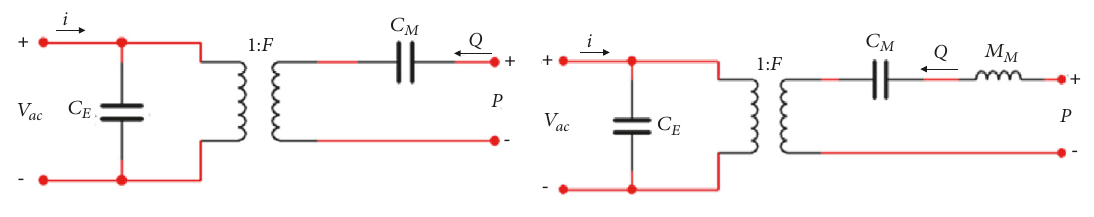
Figure 5: Two-port equivalent circuit of the piezoelectric